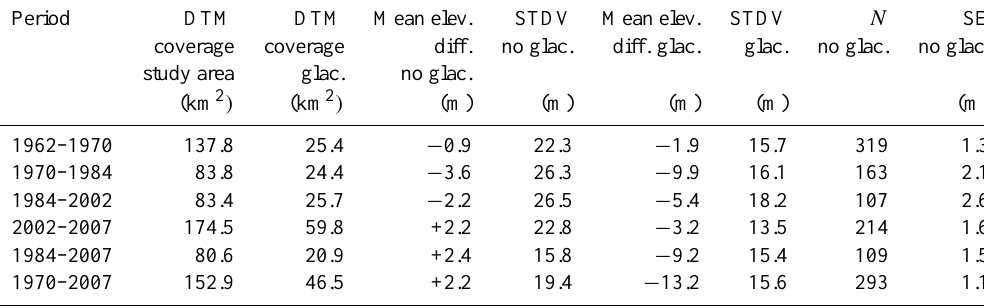
Table 2. Statistics of the DTM differences for the investigated periods. Period DTM DTM Mean elev. STDV Mean elev. STDV N SE coverage coverage diff. no glac. diff. glac. glac. no glac. no glac. study area glac. no glac. (km 2 ) (km 2 ) (m) (m) (m)